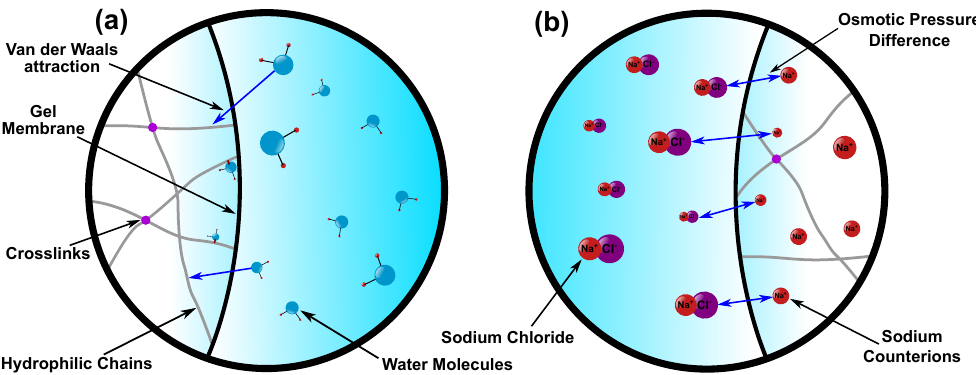
Figure 1. ( a ) Mixing Energy: attraction of the solvent (water) molecules in the external solution towards the hydrophilic polymer chains causing fluid flow into the gel. ( b ) Ionic Energy: osmotic pressure gradient resulting from the molar concentration difference between the sodium counterions inside the gel and the ionic composition of the external solution. This drives fluid either into or out of the gel depending on the sign of the osmotic pressure